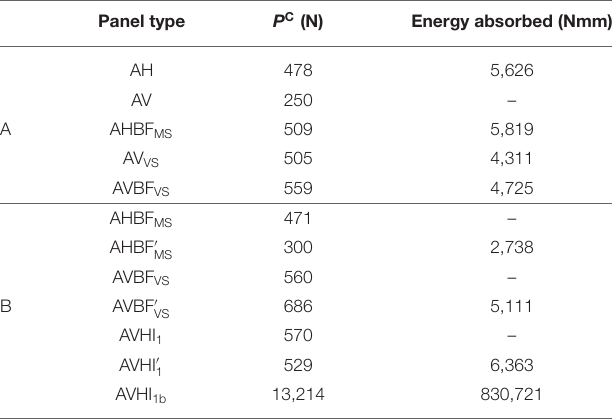
TABLE 2 | Critical buckling loads and absorbed energies from the panel cases with (A) uniform cores and ones with disruptions composed of cells with inclination angles θ 60 ◦ and α 30 ◦ ; and (B) panel cases with further disruptions and = = modified inclination angles θ 45 ◦ and α 25 ◦ all evaluated at a common = = normalized axial end-shortening ( δ/ L ) value of 5.5 %